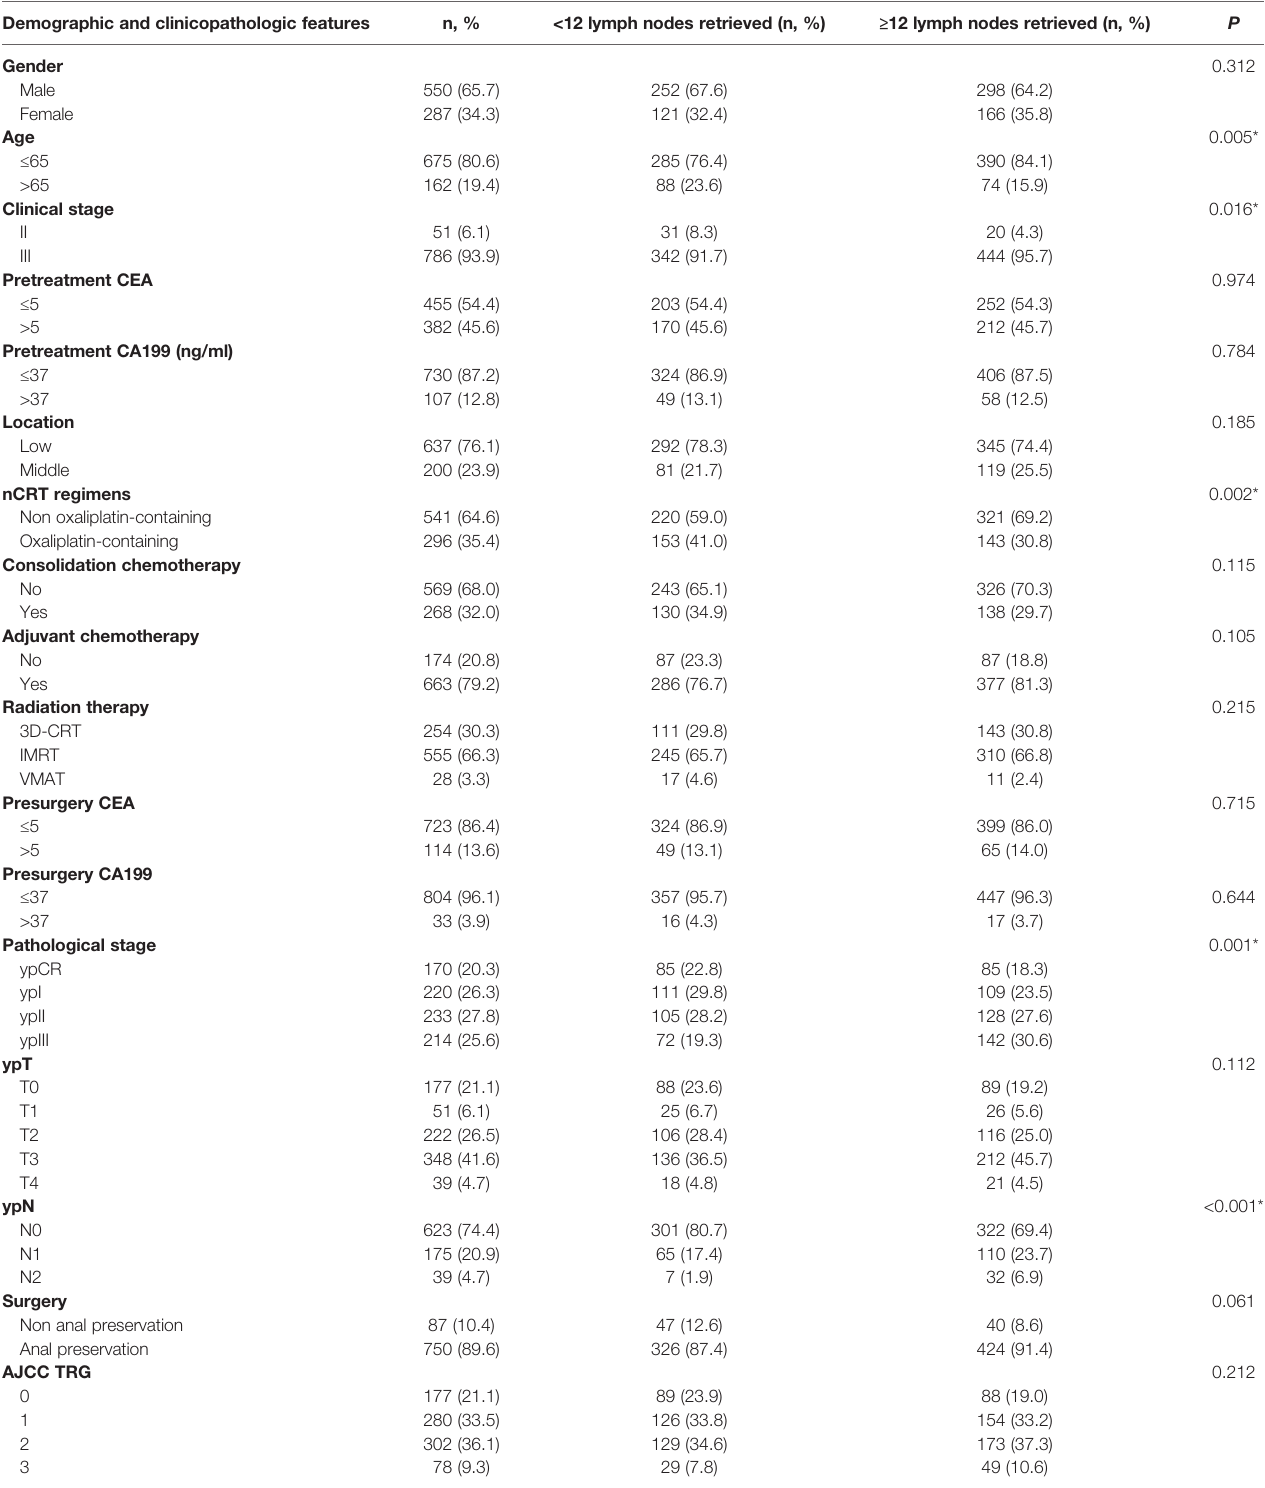
TABLE 1 | Participant